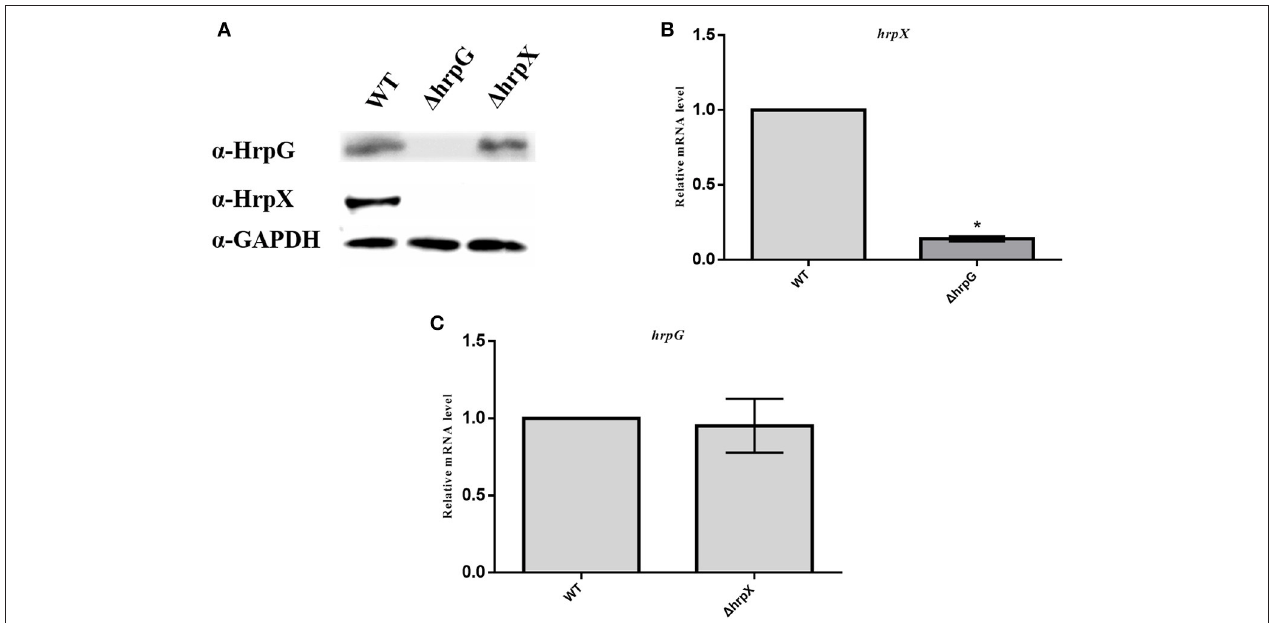
FIGURE 7 | The interaction of hrpG and hrpX in Acidovorax citrulli . (A) Western blotting analysis showed that HrpG activated HrpX. The WT, 1 hrpG, and 1 hrpX strains were cultured in liquid T3SS-inducing medium up to OD 600 = 0.5. Total cell extracts were analyzed by SDS-PAGE and immunoblotting, using specific antibodies. The experiment was performed three times. (B) Represents real-time quantitative RT-PCR to determine hrpX mRNA levels. hrpX expression was analyzed through RT-qPCR in wild-type strains Aac5 and the hrpG mutant strain, using specific primers. Bacteria were grown in liquid T3SS-inducing medium to OD 600 = 0.45 and harvested to extract total RNA. (C) Represents real-time quantitative RT-PCR to determine hrpG mRNA levels. hrpX expression was assayed through RT-qPCR in wild-type strain Aac5 and the hrpX mutant, using specific primers. All the data shown are means ± standard deviation of duplicate samples from one representative experiment and are reported as fold induction relative to expression of WT. The rpoB gene was used as a reference gene. Each column shows the mean and standard deviation. The experiment was performed three times, with similar results obtained each time. Asterisks above bars indicate significant differences as determined by t- test, p <